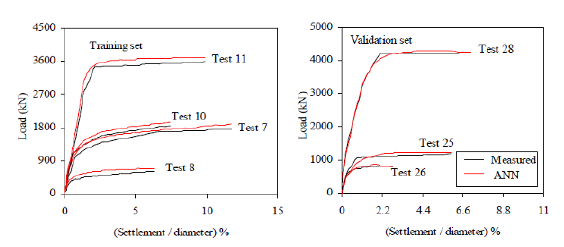
Figure 6. Some simulation results of the developed ANN Model for driven concrete piles in training and validation sets.